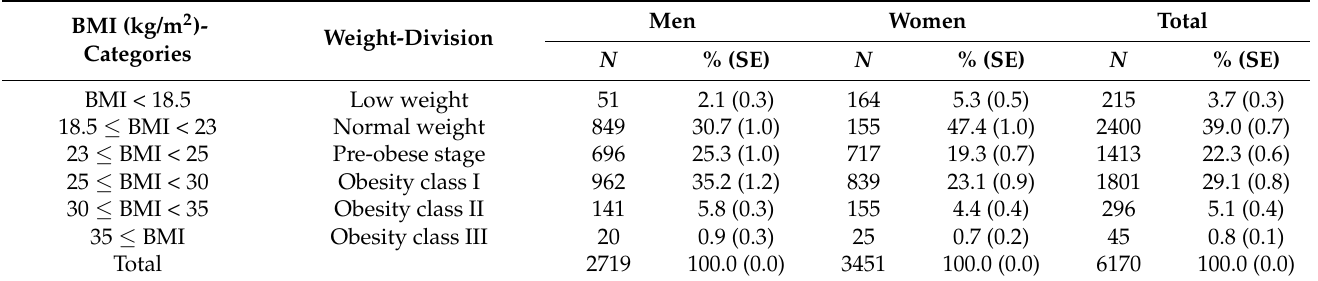
Table 1. Distribution of weight according to BMI in Korean population ( ≥ 19 years old).